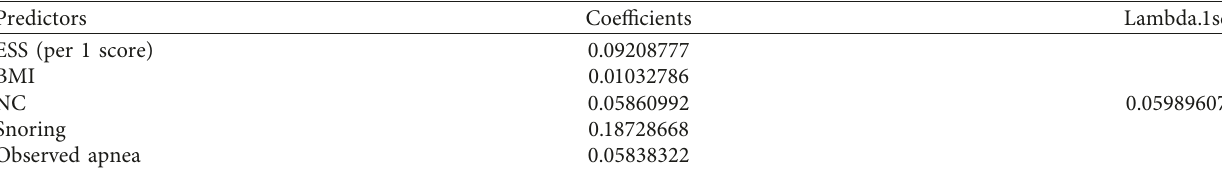
Figure 1: Demographic, anthropometric value, OSA-related signs and symptoms, and ESS score selection using the LASSO binary logistic regression model. (a) Optimal parameter (lambda) selection in the LASSO model used ten fold cross-validation via minimum criteria. The partial likelihood deviance (binomial deviance) curve was plotted versus log(lambda). Dotted vertical lines were drawn at the optimal values by using the minimum criteria and the 1 SE of the minimum criteria (the 1-SE criteria). (b) LASSO coefficient profiles of the 12 features. A coefficient profile plot was produced against the log(lambda) sequence. Vertical line was drawn at the value selected using ten-fold cross- validation, where optimal lambda resulted in five features with nonzero coefficients. LASSO, least absolute shrinkage and selection operator; SE, standard error. OSA, Obstructive sleep apnea; ESS, Epworth sleepiness scale. Table 2: Predictors of OSA according to the LASSO regression model in patients with